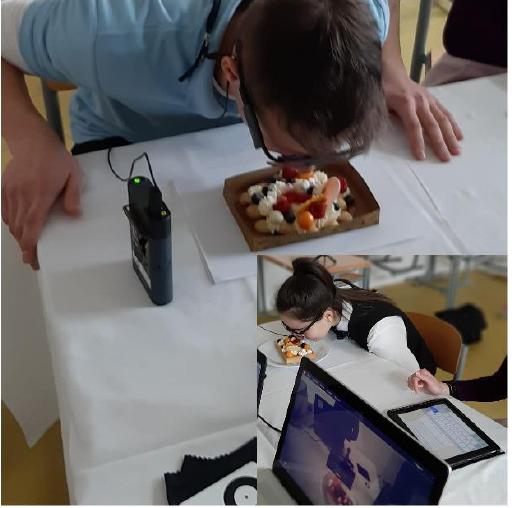
Figure 4. Evaluation of the aroma of individual visual designs of waffles. The perception of tastes is one of the most complex manifestations of human